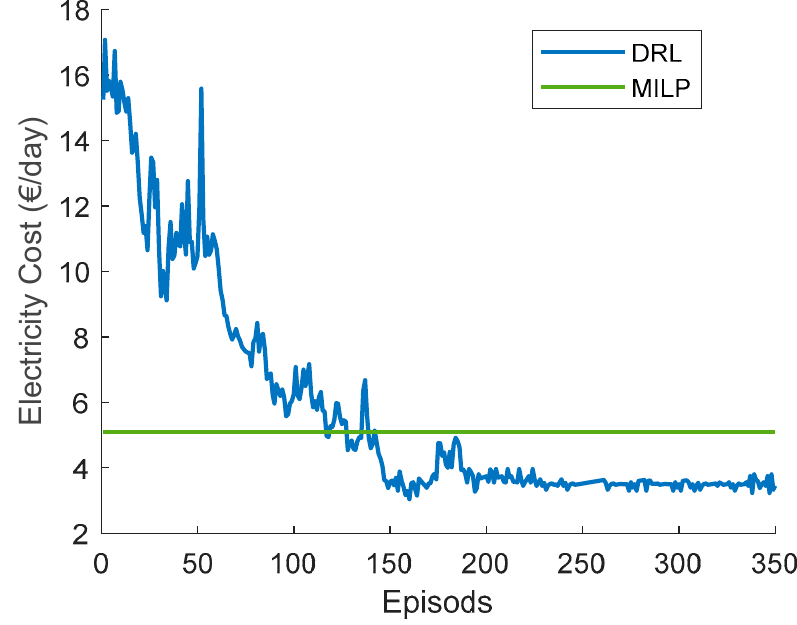
Figure 12. Total electricity costs over one day by DRL agent and MILP